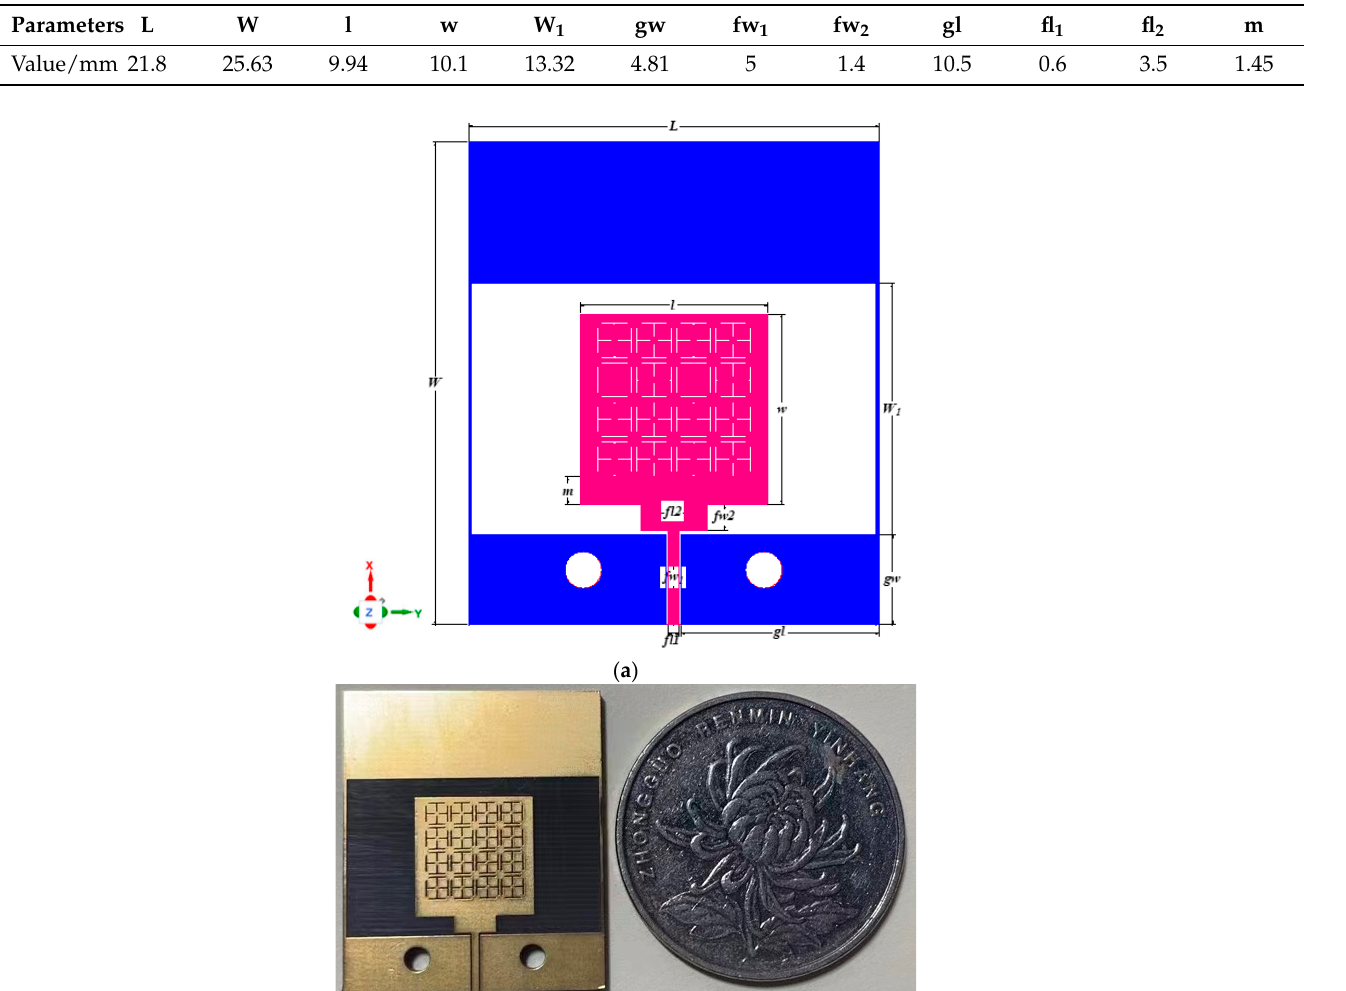
Table 1. Geometrical parameters of the UWB monopole antenna.